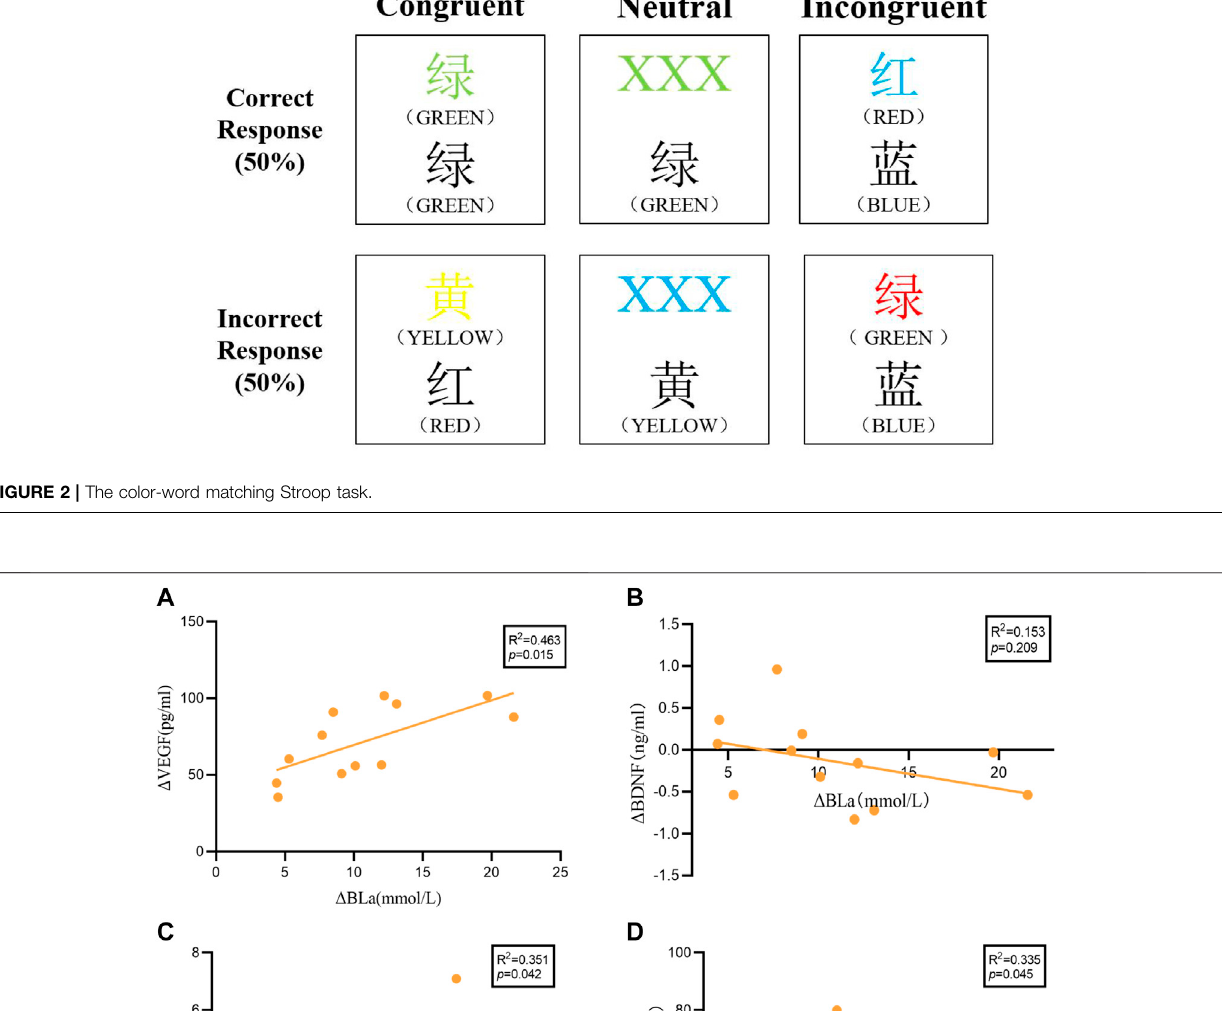
upper row consisted of ‘ XXX ’ printed in red, yellow, blue, or green and the lower row contained the words ‘ RED ’ , ‘ YELLOW ’ , ‘ BLUE ’ , or ‘ GREEN ’ printed in black. For incongruent tasks, the color words in the upper row were printed in an incongruent color (e.g., RED was printed in blue) and the lower row contained color words printed in